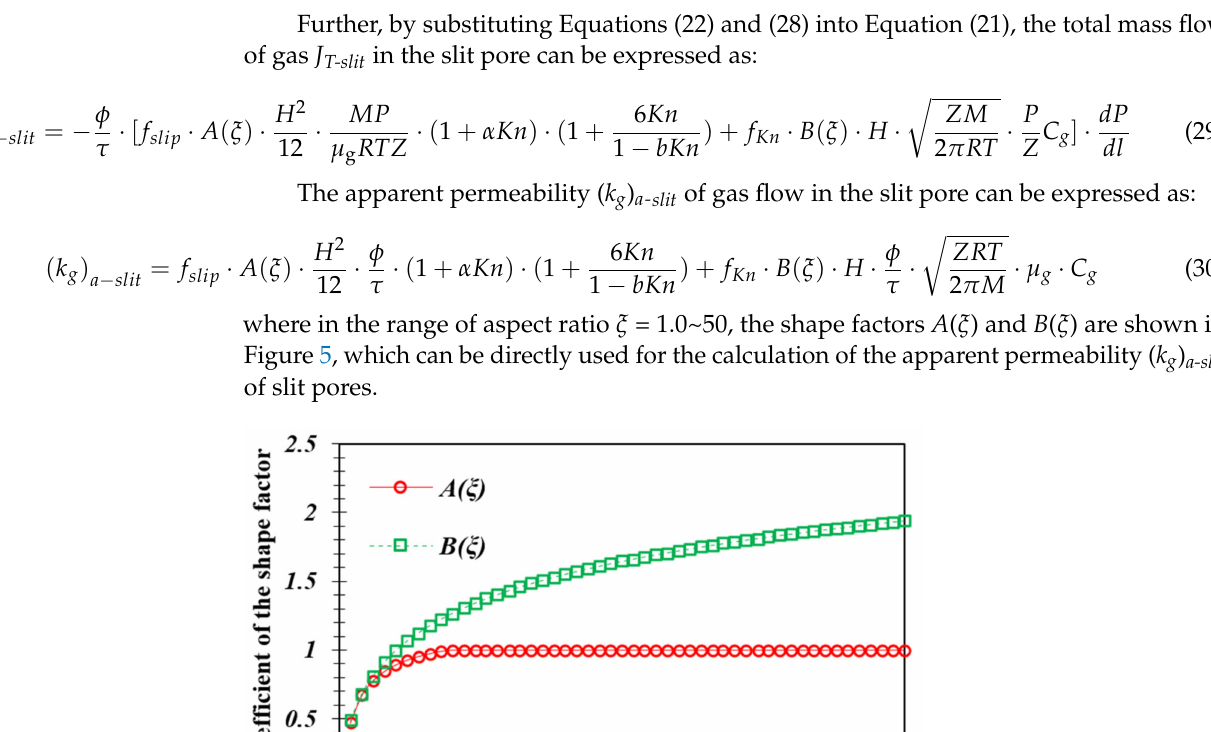
Figure 4. Weight coefficients with different Kn in slit pores.